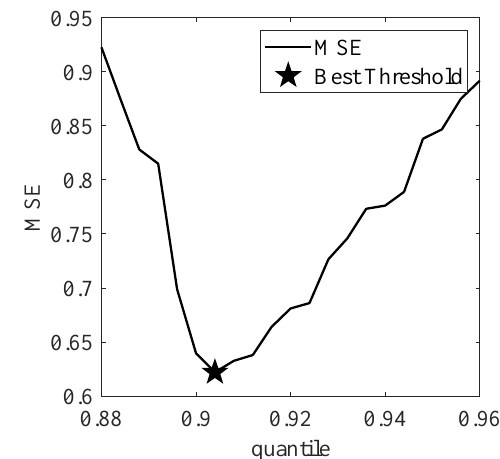
Figure 2. Threshold selection using MSE